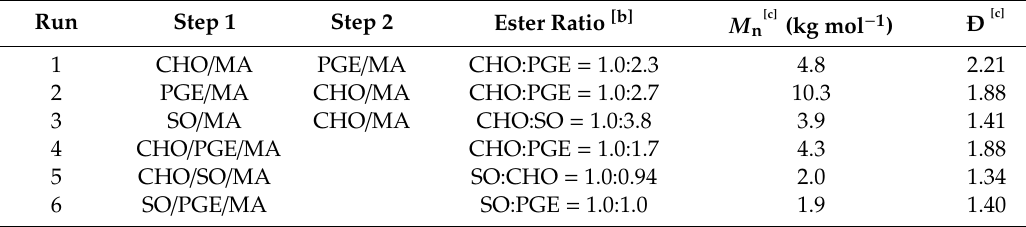
Table 4. Terpolymerization of MA with two di ff erent epoxides